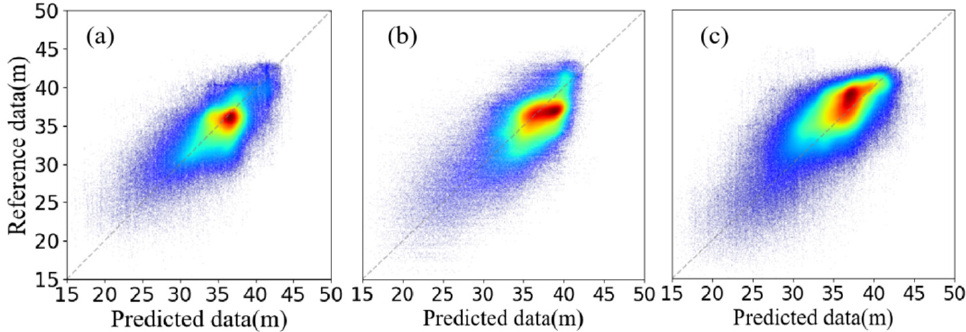
Figure 10. Scatter density distribution of predicted water depths for ( a ) Model I, ( b ) Model II, and ( c ) Model III.